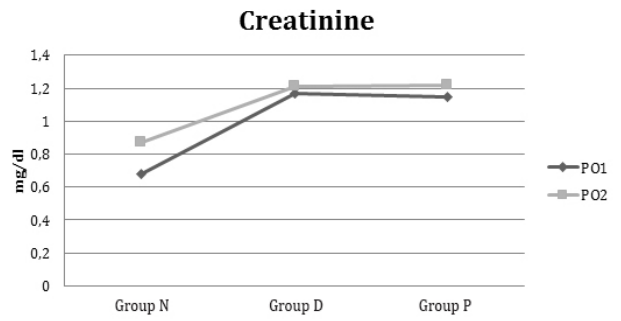
Fig. 2 - Evolution of creatinine from first postoperative day to second postoperative day in NAC, Dopamine and Placebo Groups.